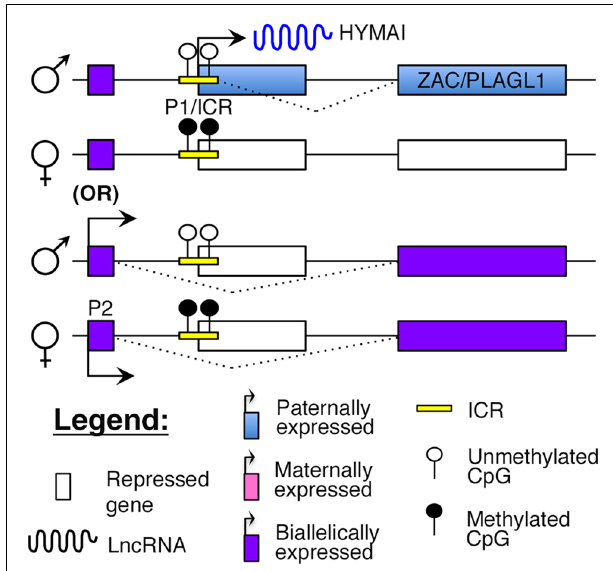
FIGURE 4 | Proposed model of imprinting at the ZAC–HYMAI locus: ZAC/PLAGL1 and the lncRNA HYMAI are both paternally expressed from a common promoter that is also the ICR. However, in some tissues, ZAC is biallelically expressed from an upstream